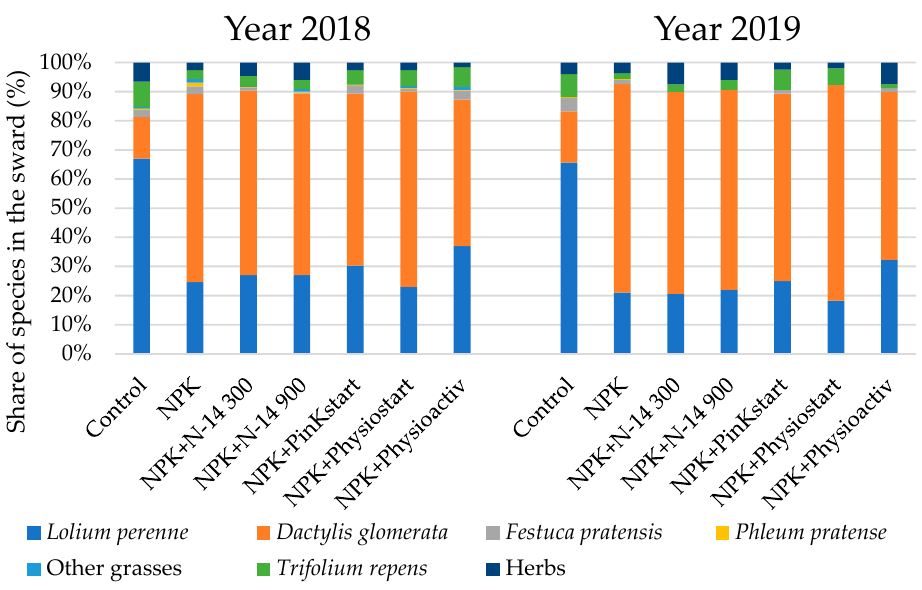
Figure 3. Percentage share in biomass of plant species in the grass mixture (GM) sward in 2018 and 2019 (average of three cuts).